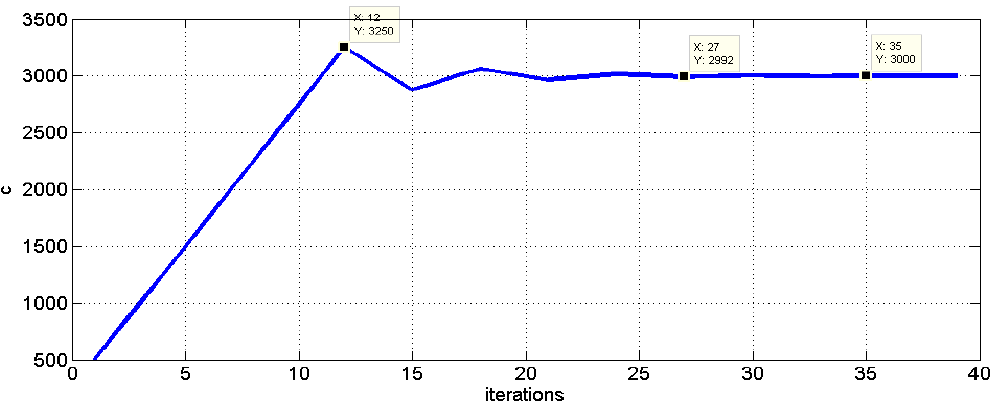
Figure 7. Temporal determination of C = c = 3,000 m/s for the above